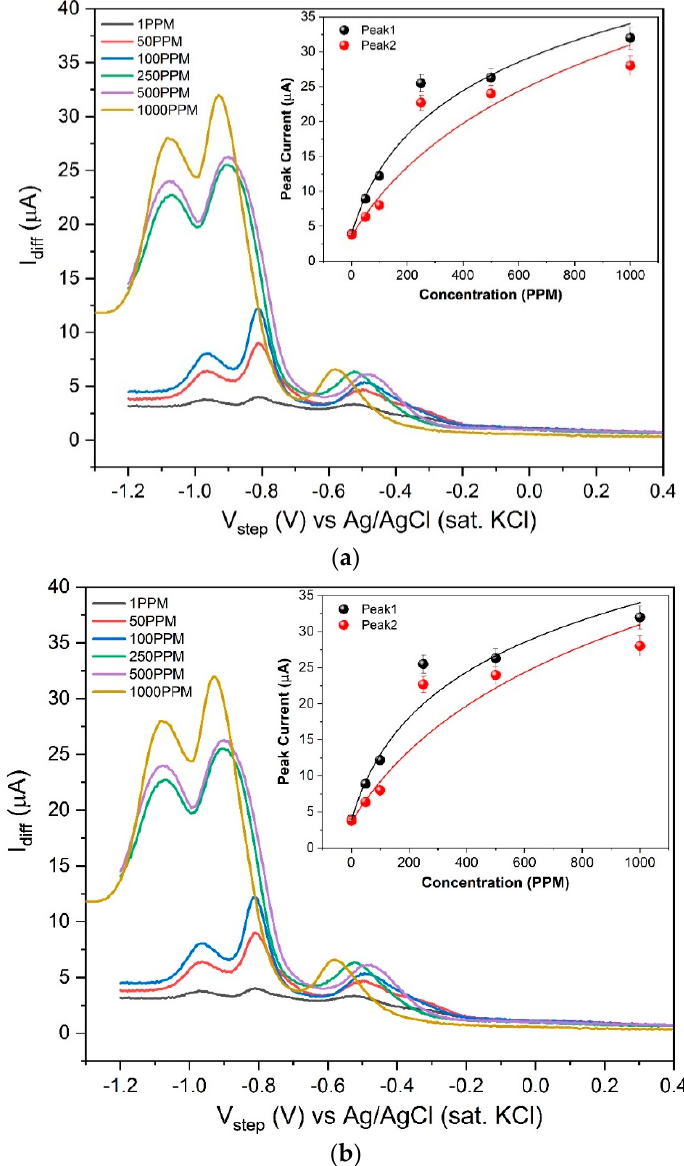
Figure 5. Square wave voltammetry performed using [EMIM][BF 4 ]-modified GCE in two different analytes with varying concentration. SQWV parameter: frequency 25 Hz, amplitude of 25 mV and step size of 5 mV. Calibrated dose response of ( a ) 2,6 DNT showing two distinct peaks which varies with concentration (inset Figure 2a); ( b ) ENB showing one distinct peak which varies with concentrations. (inset Figure 2b).